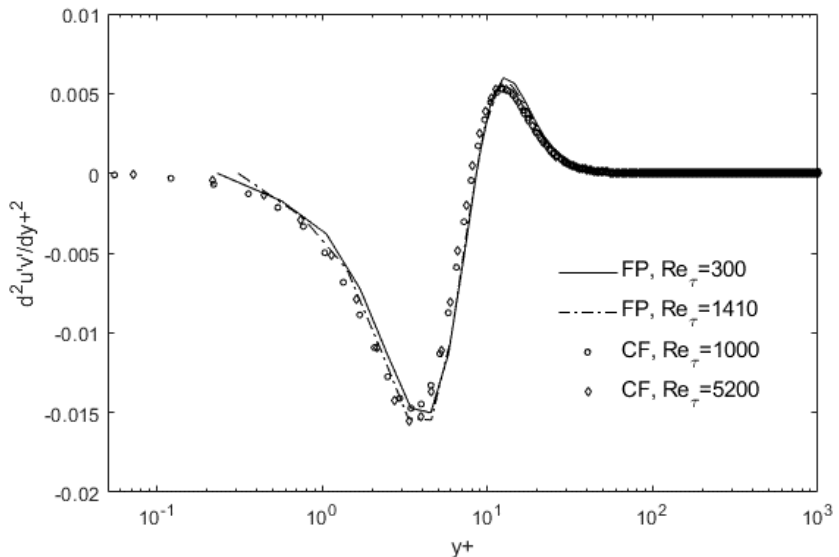
Figure 4. The dissipation scaling of d 2 u’v’/dy+ 2 . DNS data of Spalart [13] for FP and Graham et al. [12] for CF are used.